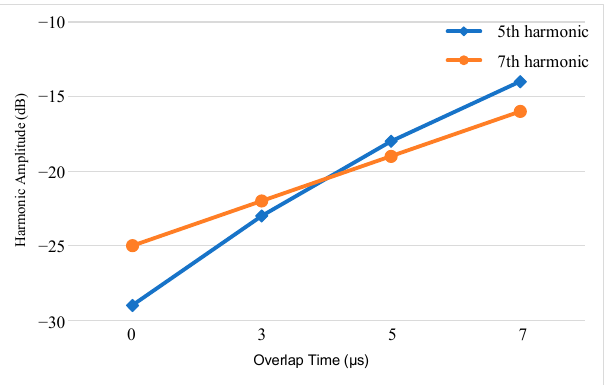
Figure 13. Experimental waveforms of the 5th and 7th harmonic amplitudes with different overlap times at 10 kHz switching frequency.